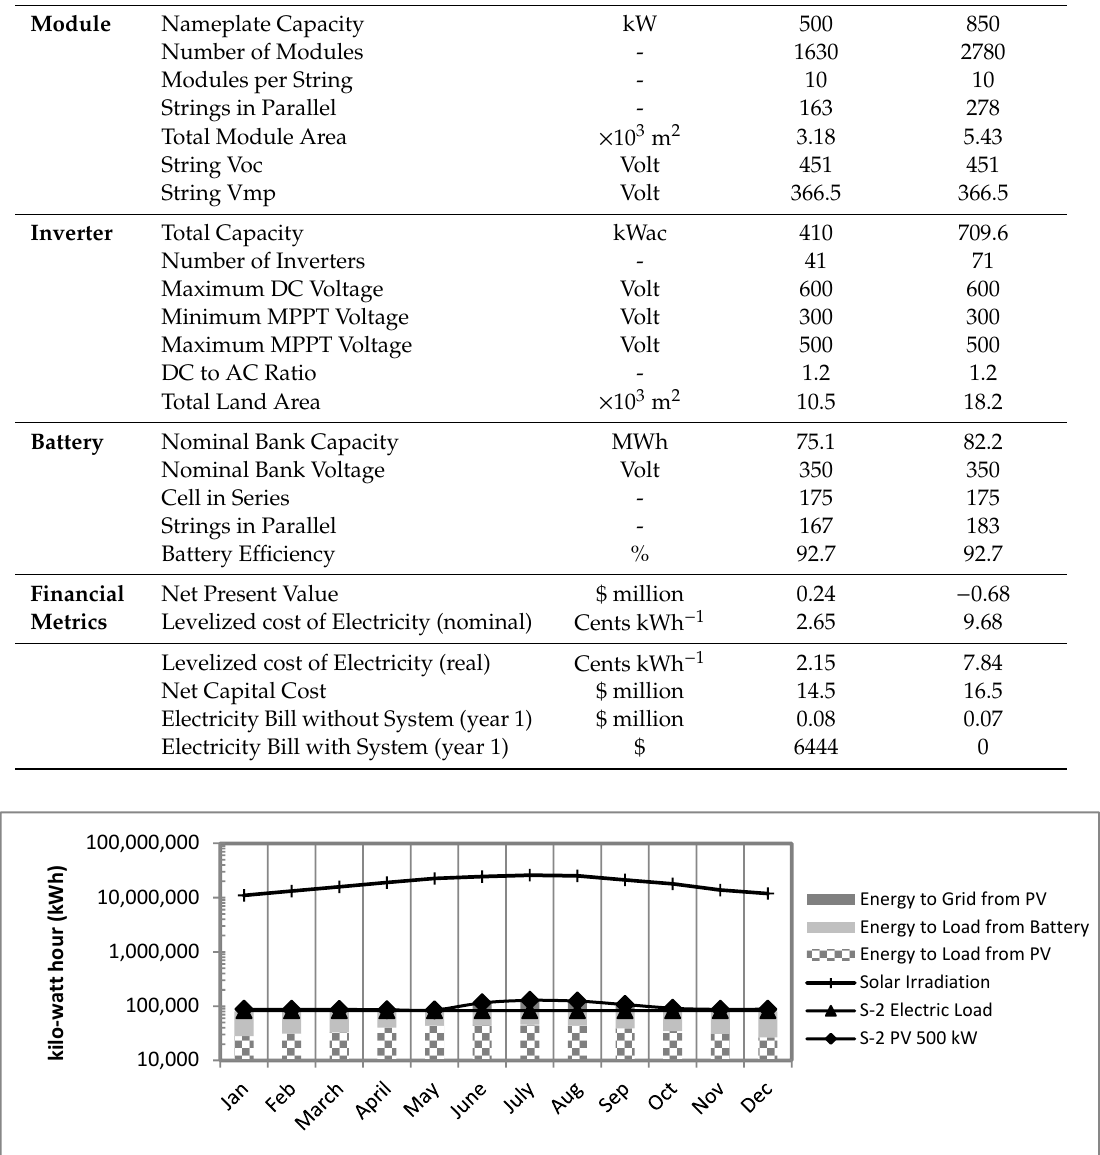
Figure 4. Inputs of electric load and solar irradiation and outputs for photovoltaic (PV) energy generation for the drinking water treatment facility for scenario S-2 (energy consumption of water treatment facility excluding distribution pumps).